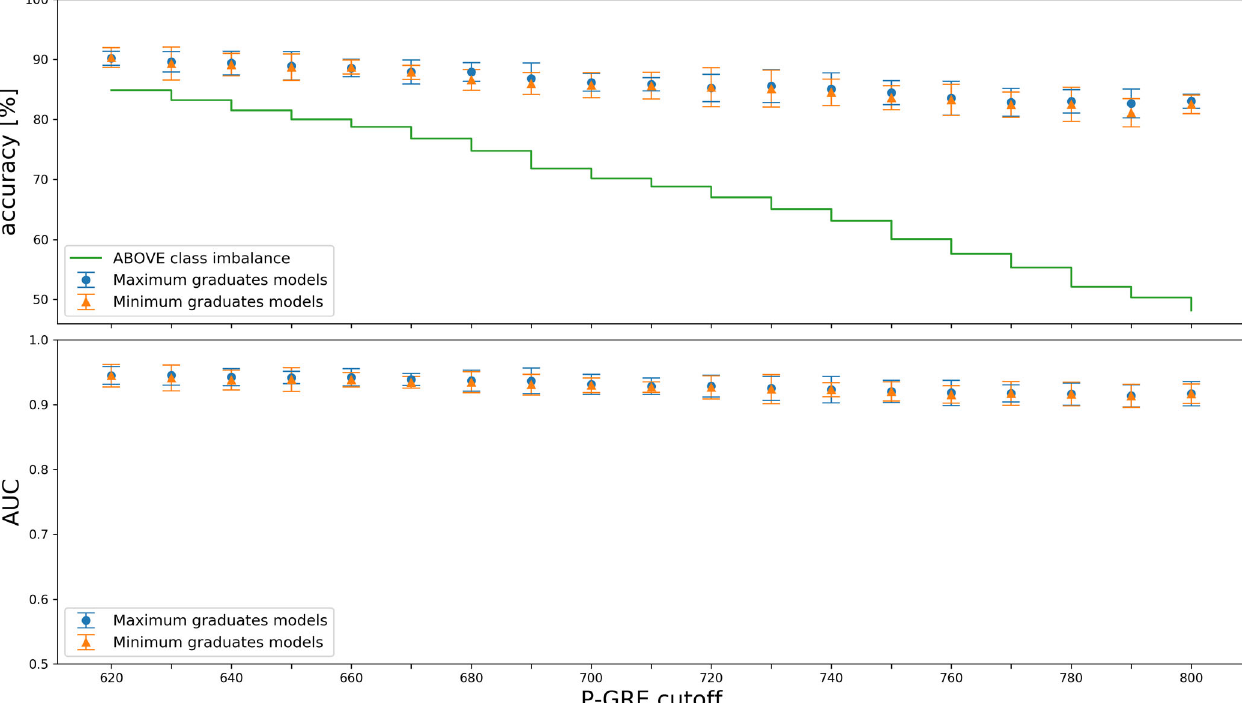
FIG. 4. Overall performance of the conditional inference forest. The standard errors of the K -fold ( K ¼ 10 ) estimates are indicated by the error bars. While the ABOVE class imbalance is very high for lower cutoffs, the accuracy standard errors are always above the imbalance level. The AUC score is mostly above 0.9, which Hosmer et al. categorizes as “ outstanding ” [31].